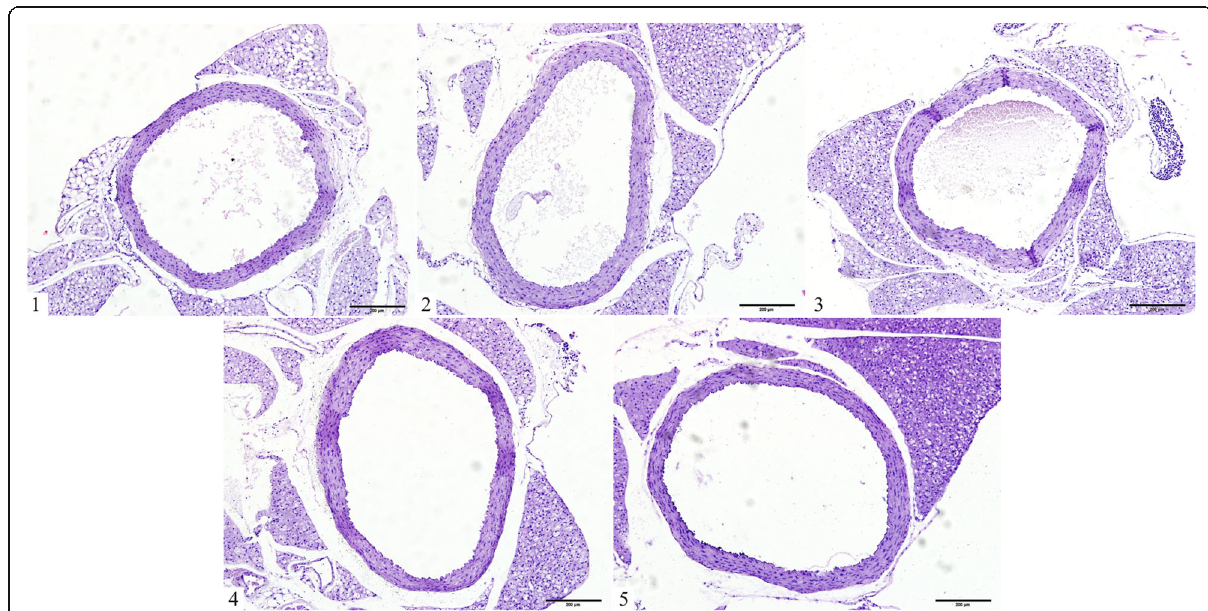
Fig. 6 Representative images of aortic remodeling in different groups following HE staining (magnification, × 40). 1,control group; 2,model group; 3, L -NAME+AqE group; 4, L -NAME+XJEK group; 5, L -NAME+fosinopril group. The model group demonstrated notable vascular remodeling compared with the control group. However, these pathological changes could be markedly reversed following treatment with AqE for the last 4 weeks of treatment, and similar effects could be achieved when XJEK and the positive control fosinopril were